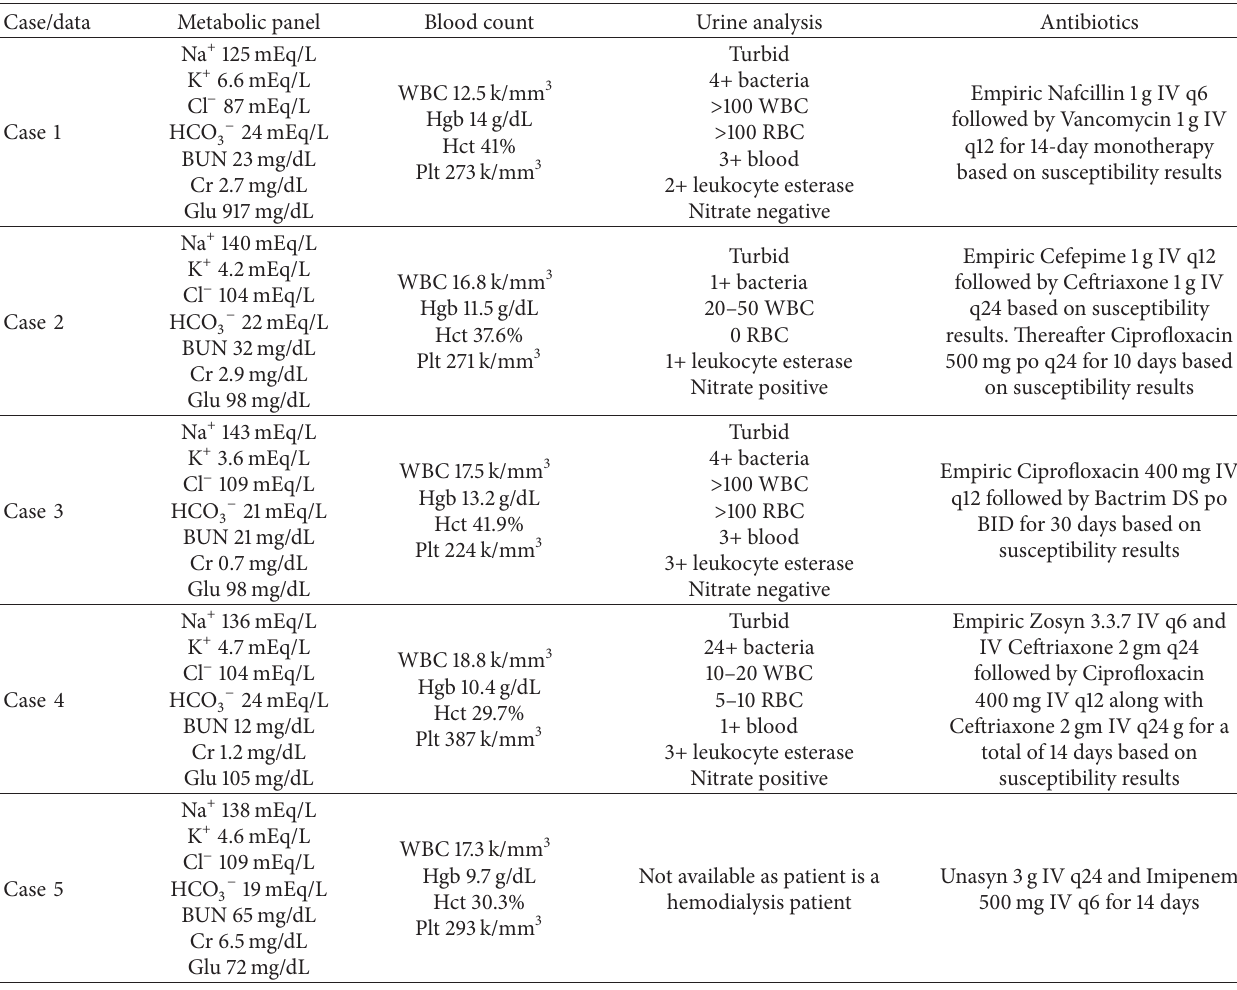
Table 1: Patient laboratory data and antibiotic treatment.